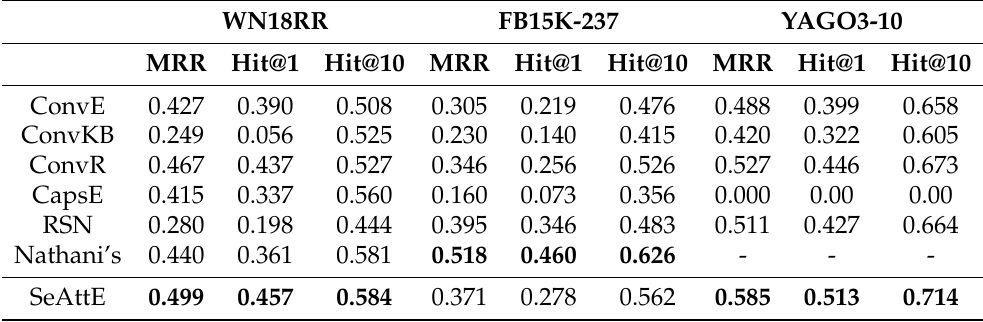
Table 3. This is the comparison between SeAttE and deep learning models on WN18RR, FB15K-237 and YAGO3-10. The best results of each metric for each dataset are marked in